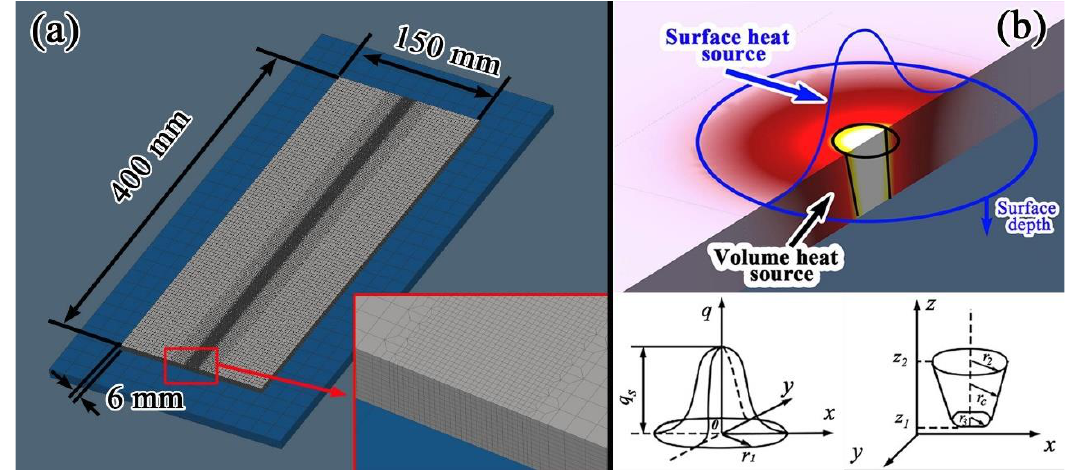
Figure 1. Finite element model: ( a ) Geometric model; ( b ) Heat source